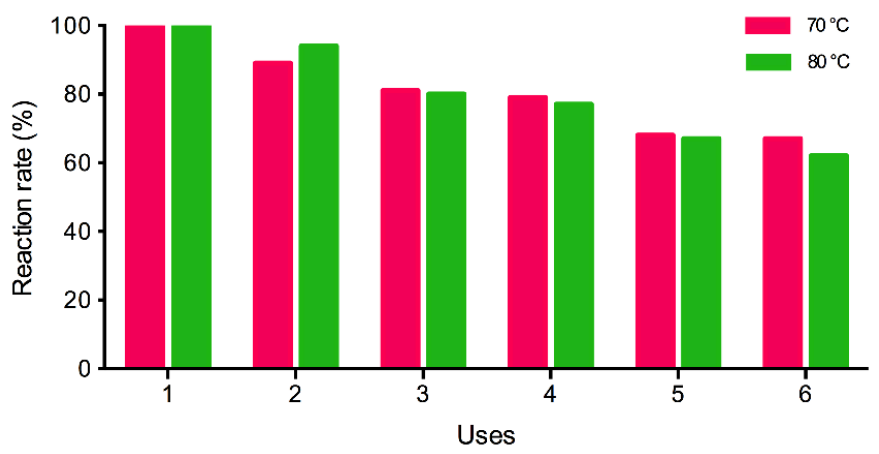
Figure 6. Reusability test of Novozym ® 435 for EHMH synthesis at 70 ◦ C, 10% EH excess and 80 ◦ C, 20% EH excess; 350 rpm, 2.5% ( w/w ) biocatalyst. Table 2. Product concentrations (% w/w ) and productivity of the enzymatic synthesis of EHMH at 70 ◦ C, 10% EH molar excess and at 80 ◦ C, 20% EH molar excess, both with a single use and with six uses of the biocatalyst.